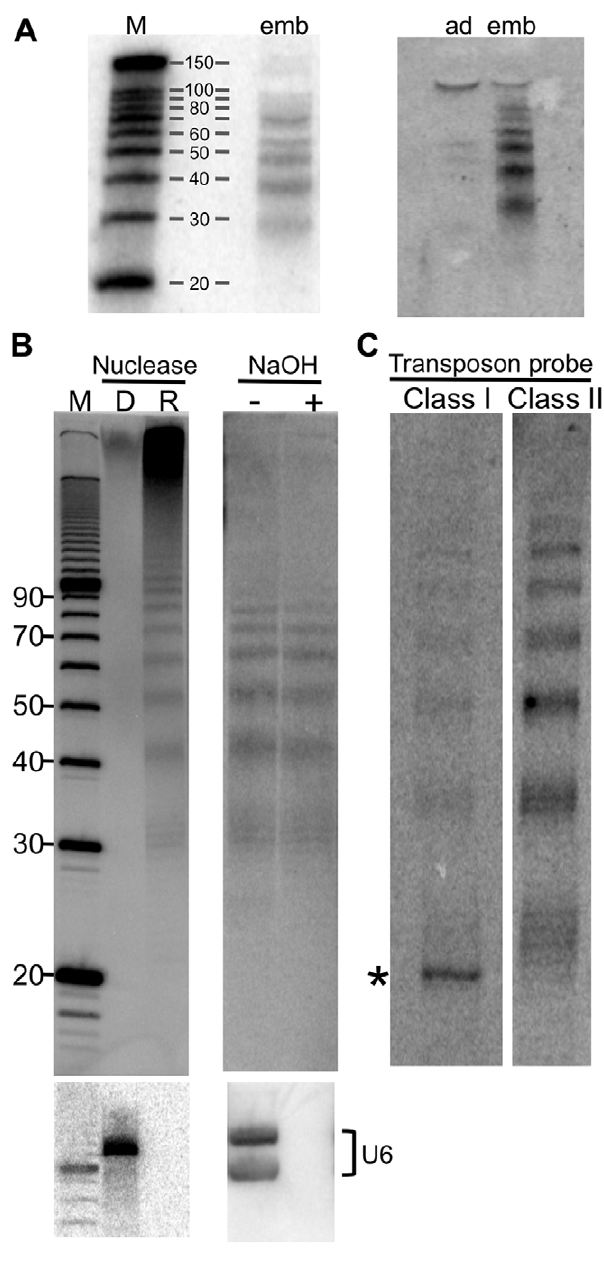
Figure 1. Characterization of small nucleic acid pieces. ( A ) Northern analysis of nucleic acid isolated from wildtype embryos (emb) or adults (ad) using the ‘‘total RNA’’ protocol, and hybridization with probes complementary to the 3 9 UTR of clec-67 (Materials and Methods; Figure S1). M, RNA decade markers (Ambion). ( B ) A representative northern blot is shown (n $ 3) preformed as in (A) using embryo samples and subjecting ‘‘total RNA’’ to various treatments prior to electrophoresis and northern analysis: D, DNase treatment; R, RNase treatment, NaOH, alkaline hydrolysis. M, 10 bp DNA ladder (Invitrogen). Blots were reprobed for U6 snRNA to confirm specificity of various treatments (bottom panels). In different experiments, U6 snRNA migrated either as a single or double band. ( C ) A representative northern blot is shown (n $ 2) performed as in (A) for embryo ‘‘total RNA’’ using probes for Class I or Class II transposons (see Materials and Methods). Asterisk marks an RNase sensitive band. ImageQuant software was used to calculate the relative radioactivity hybridizing to Class 1 and Class II transposons (1:4.4); radioactivity in the entire lane, excluding the RNase sensitive band, was evaluated.